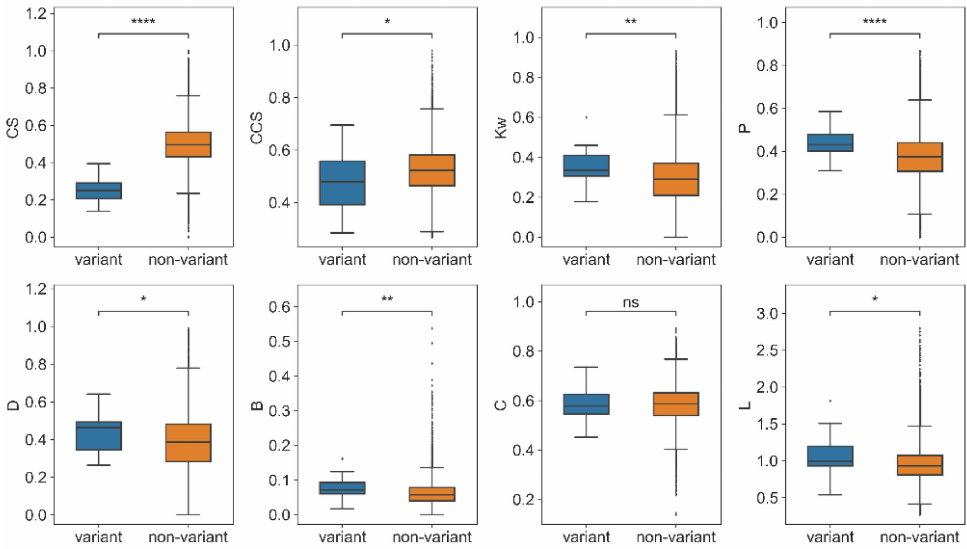
Figure 6. Comparison of the network features of the variant and non-variant groups. * p < 0.05; ** p < 0.01; **** p <